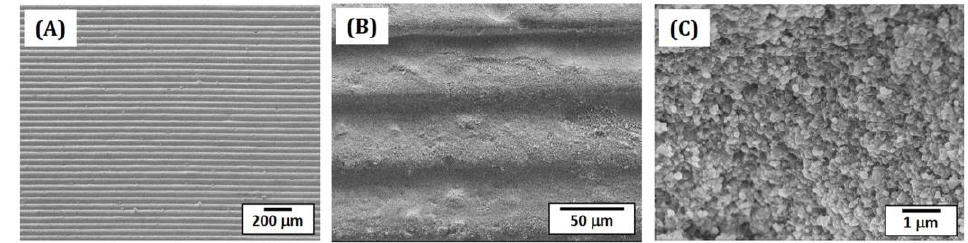
Figure 10. FE-SEM images showing free surfaces ( A , B ) and fracture surface ( C ) of as-printed 5Y-PSZ disks in the building direction.